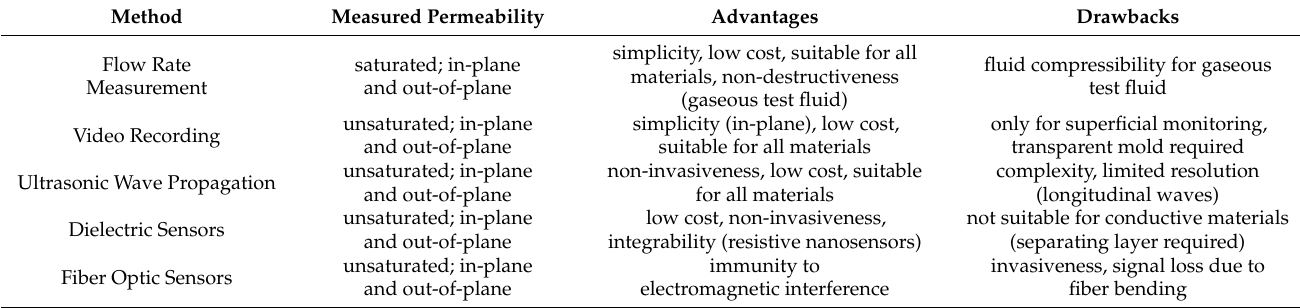
Table 1. Experimental methods for permeability